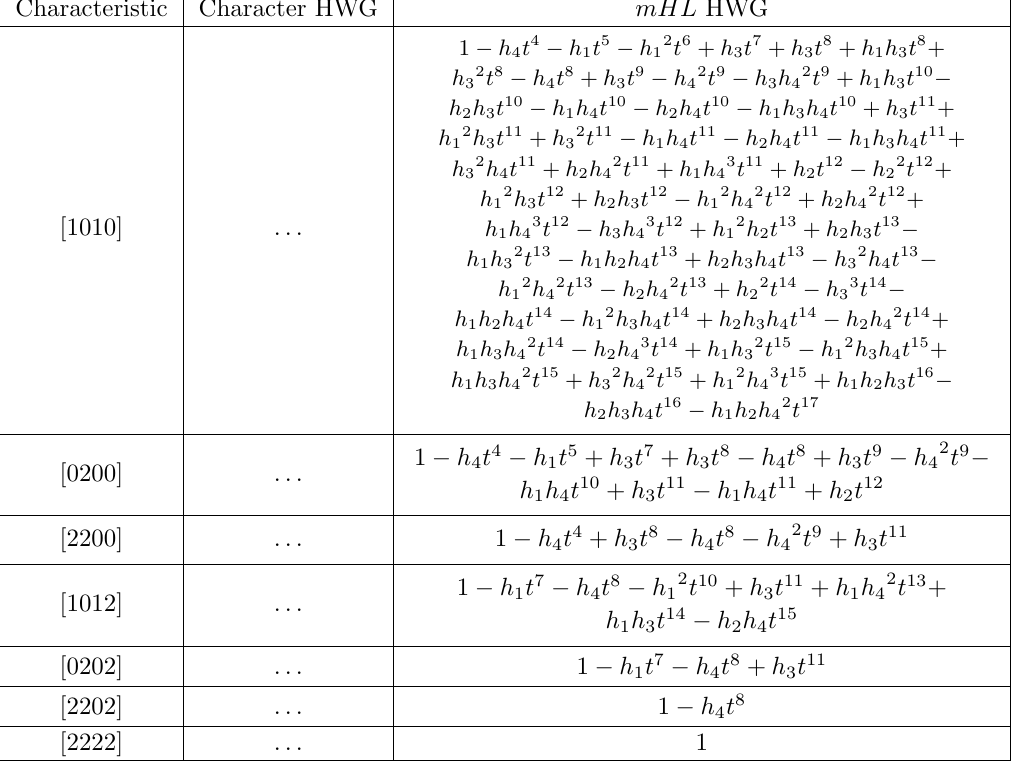
Table 9 . F 4 orbits and HWGs (B). An mHL HWG of 1 denotes mHL F 4